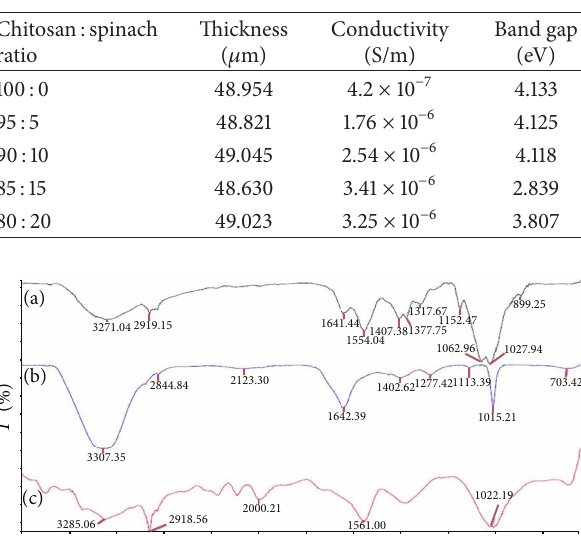
Table 1: Thickness, conductivity, and band gap energy of chitosan and chitosan-spinach blend films.